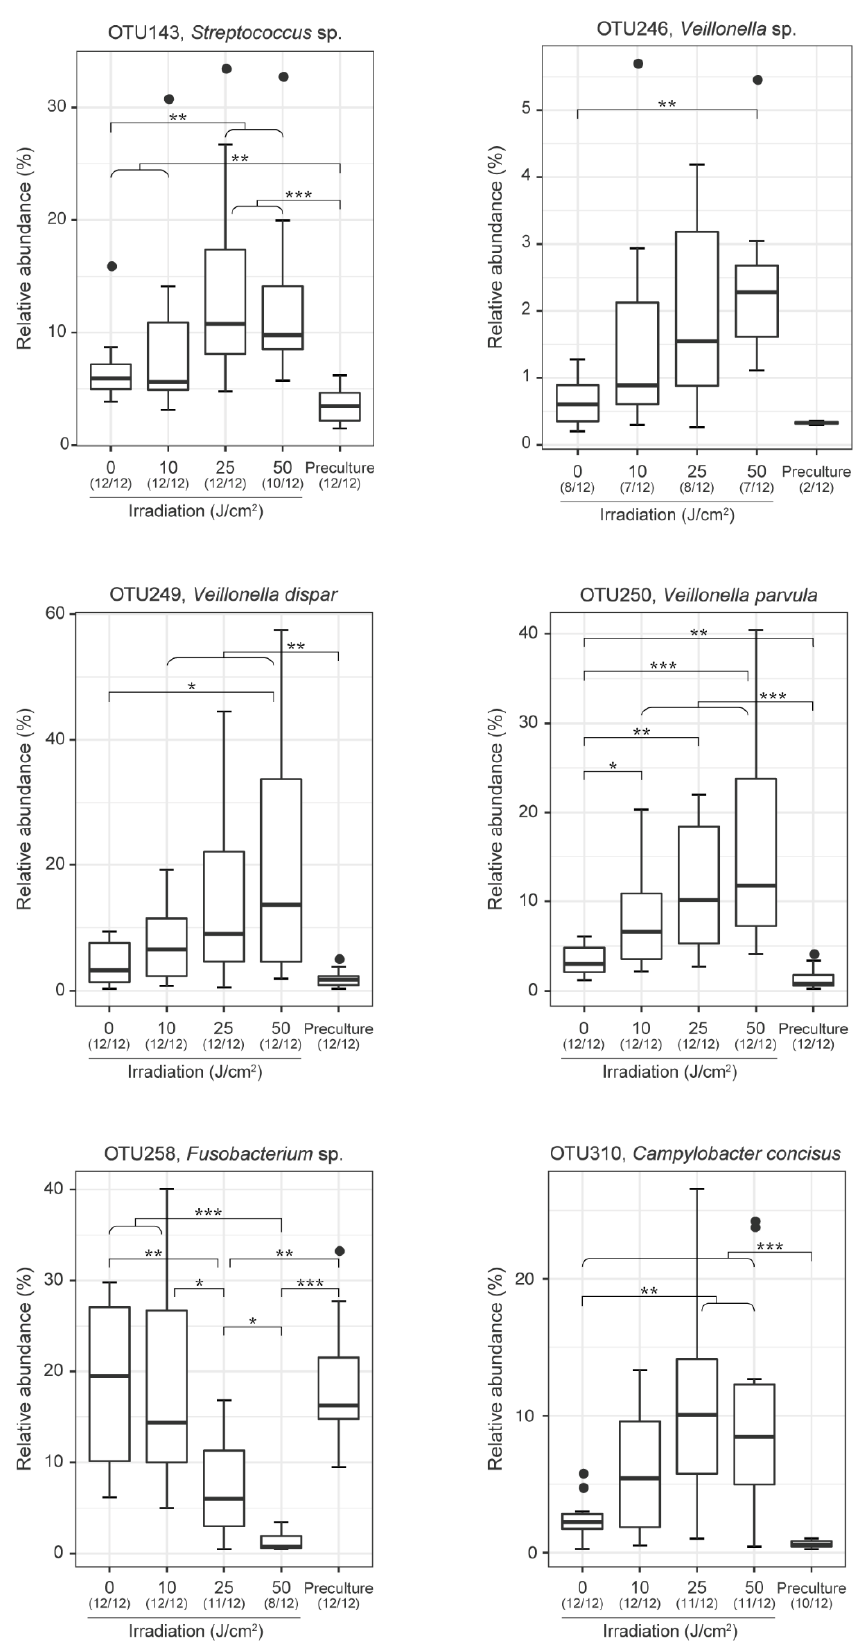
Figure 6. Relative abundance of the six representative operational taxonomic units (OTUs) altered by violet LED irradiation (* p < 0.05, ** p < 0.01, *** p < 0.001, Wilcoxon rank-sum test).